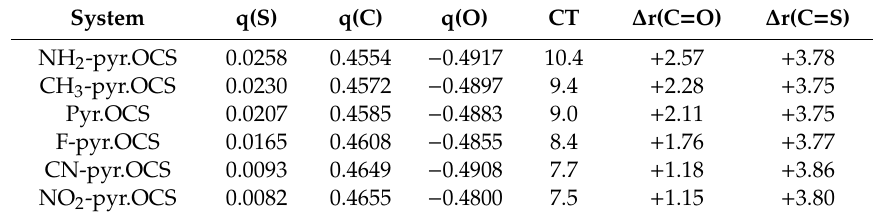
Table 4. Natural Bond Orbital (NBO) charges (e) on the S, C, and O atoms of OCS, charge transfer (me) from pyridines to OCS, and variation of the C = O and C = S distances (mÅ) in the A complexes a,b . System q(S) q(C) q(O) CT ∆ r(C = O) ∆ r(C = S)